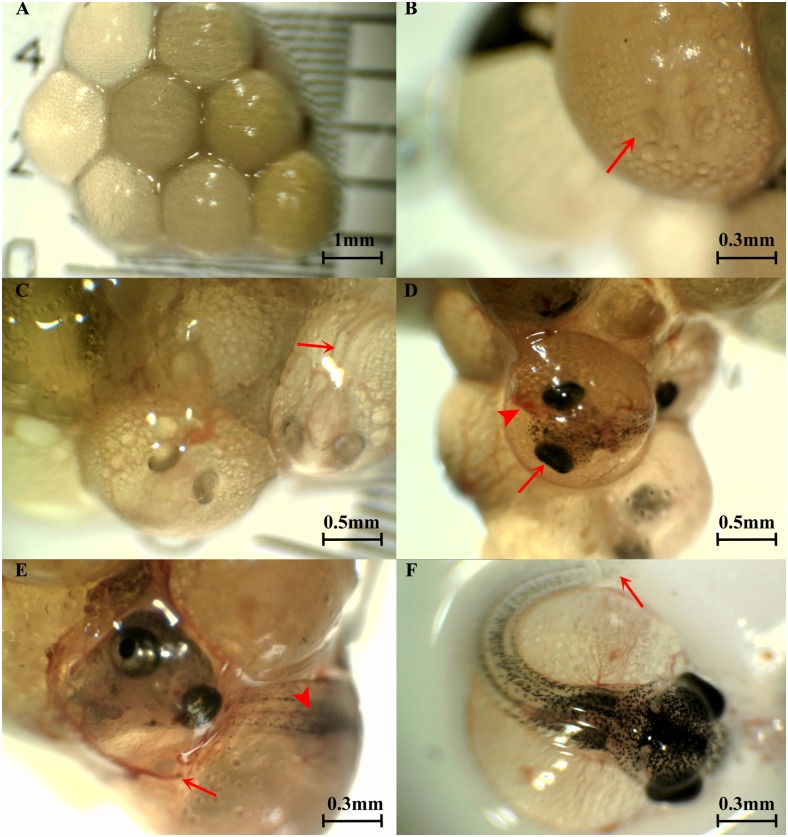
Panel showing mature eggs and embryos of G. holbrooki at various developmental stages.(A) Mature unfertilized eggs with no sign of cell division; (B) Stage I embryos with rudimentary optic cupules/eyes (arrow); (C) Stage II embryo with anterior neural tube broadened (arrow); (D) Stage III embryo with eye pigmentation prominent (arrow) and visible vitteline veins (arrow head); (E) Stage IV embryo with fine capillaries on the surface of the pericardial sac (arrow), melanophores on the tail (arrow head) and visible gill slits and (F) Embryo at late developmental stage (Stage V), showing the caudal fin rays (arrow). At this stage the mouth and nostrils are also visible through the pericardial sac [17].